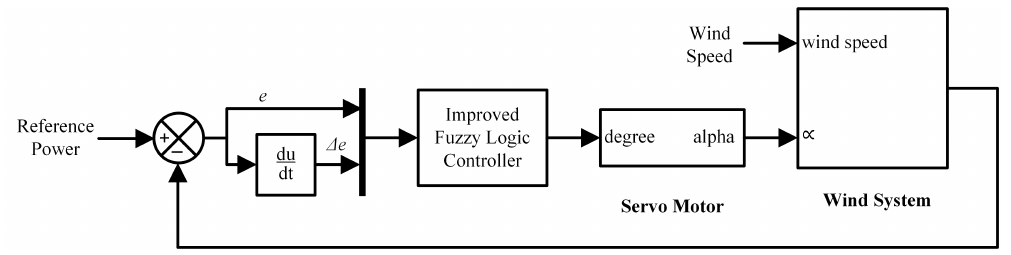
Figure 4. Fuzzy-based control system of a wind turbine.